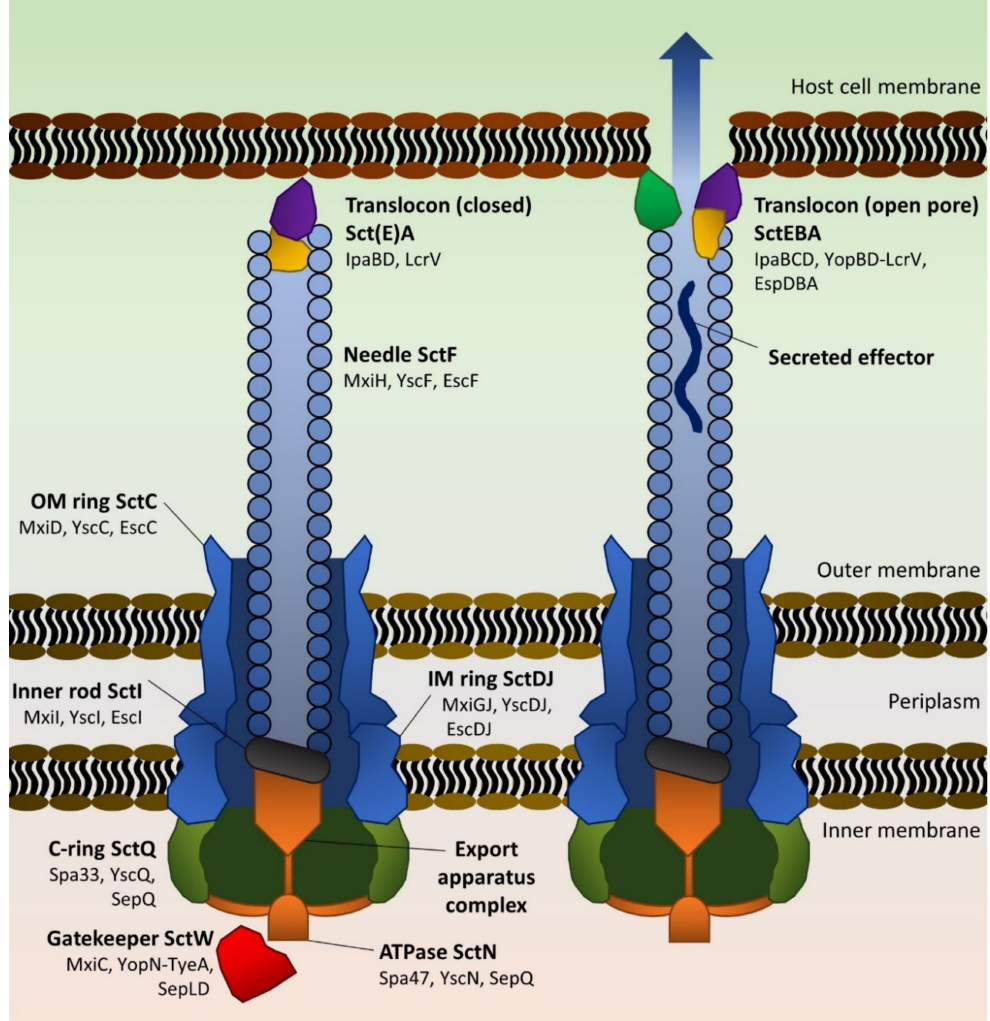
Figure 1. Schematic of type 3 secretion systems. The major structural rings (C-ring in olive, inner / outer membrane sca ff old rings in blue) support the ATPase-containing export apparatus (orange), which is linked via an inner rod adaptor helix to the needle filament (grey oblongs and blue circles, respectively). Tip and gatekeeper proteins (purple, yellow, red) initially block the needle and prevent e ff ector translocation (left) until the complex senses host cell contact—note that SctE (IpaB) has only been shown to play a role in blocking secretion in Shigella . Rearrangements then permit hydrophobic pore formation (purple, green) in the eukaryotic membrane and e ff ector secretion (right). Proteins are not shown to scale. Adapted from